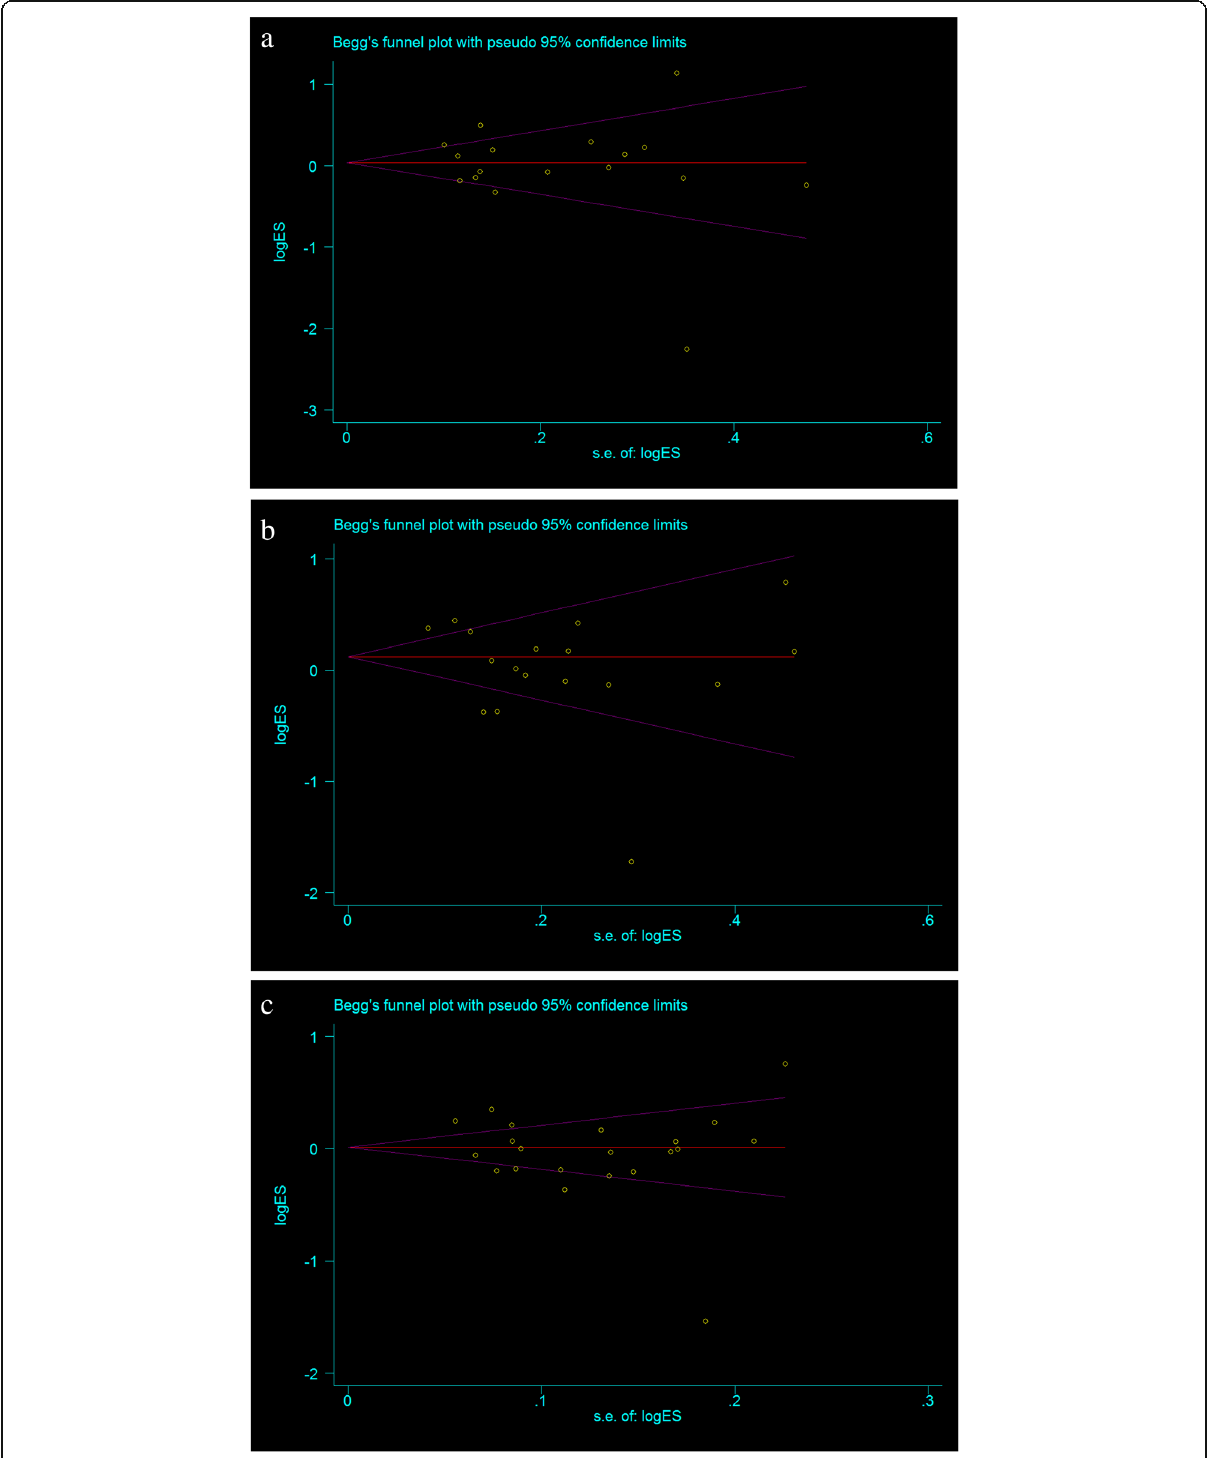
Fig. 3 Sensitivity analysis examining the association between the CEBPE rs2239633 polymorphism and risk of childhood ALL under these models (CC vs CT + TT, CC + CT vs TT, C vs